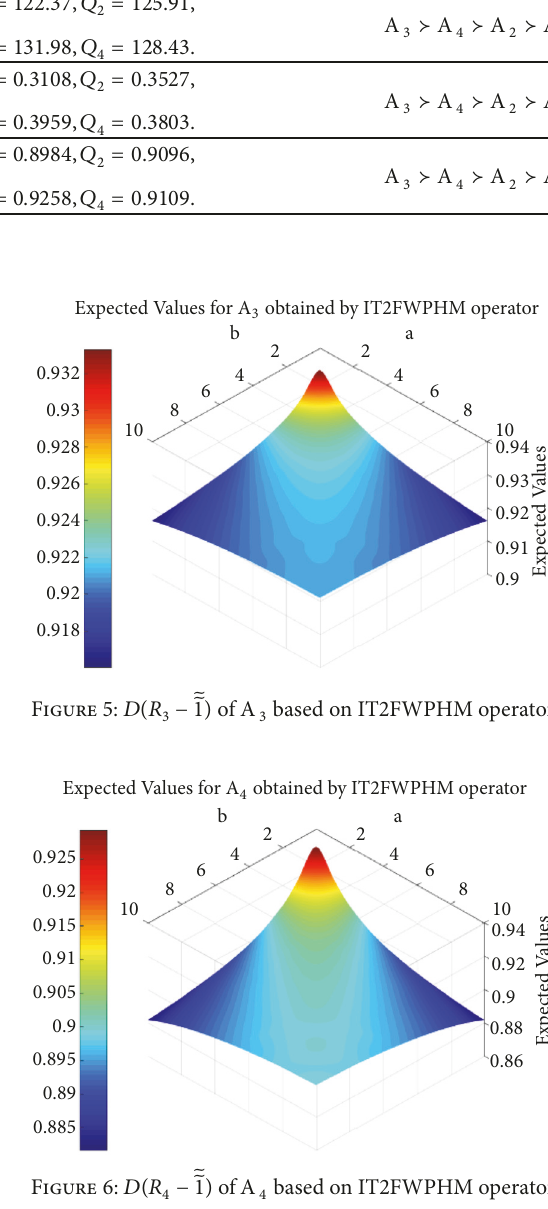
[19] based on the GTIT2FWA operator ( 𝜆 = 1 ) and TIT2FHA operator ( 𝜆 = 1 ) and Wang et al.’s method [22] based on the TIT2F weighted generalized HM (TIT2FWGHM) operator ( 𝑝 = 𝑞 = 1 ) in order to address the FELSP selection